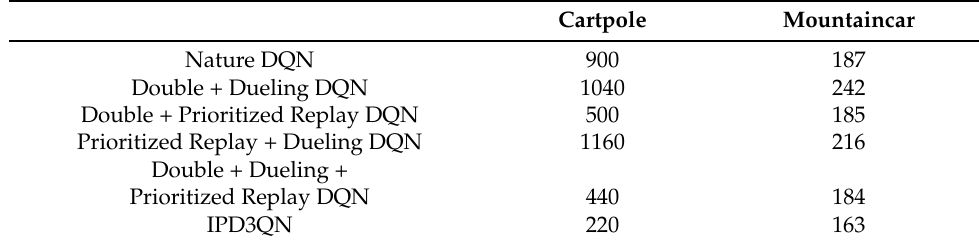
Table 4. Comparison Of Convergence Speed In Two Environments.